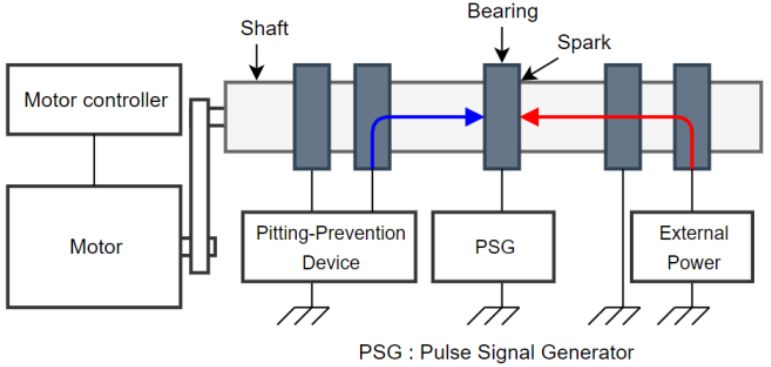
Figure 4. The schematic diagram of the experimental setup for electrical pitting prevention device.